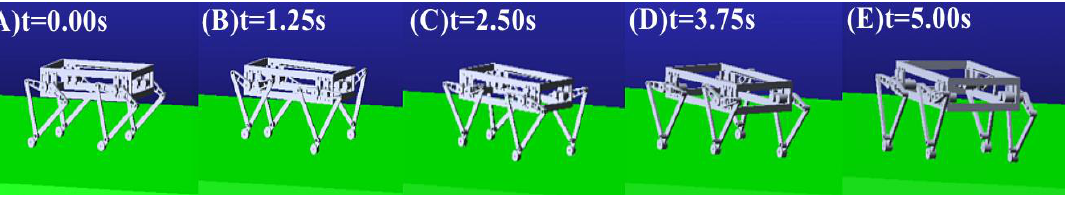
Figure 13. Schematic diagram of simulation process using cascade PID control system in a complete gait cycle.